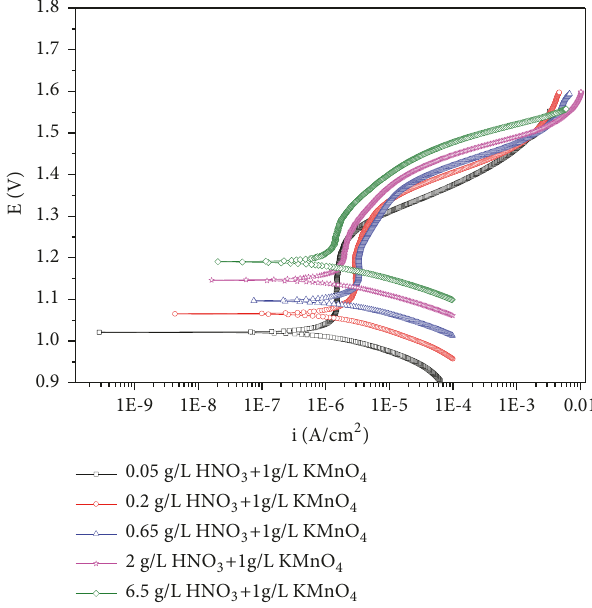
Figure 4: The potentiodynamic polarization curves of 304L SS in acid KMnO 4